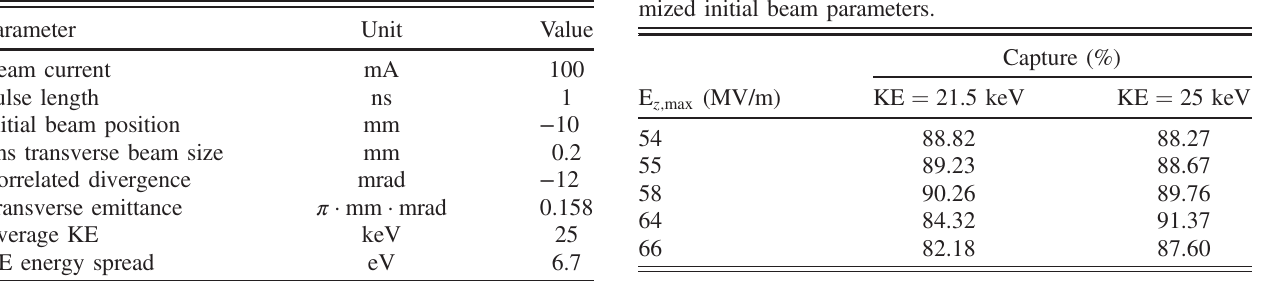
TABLE III. Initial electron beam parameters.